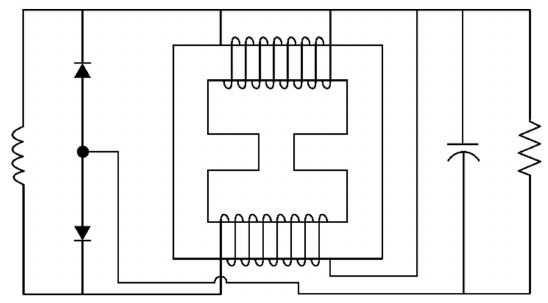
Figure 5. Winding arrangement of the proposed CICDR.